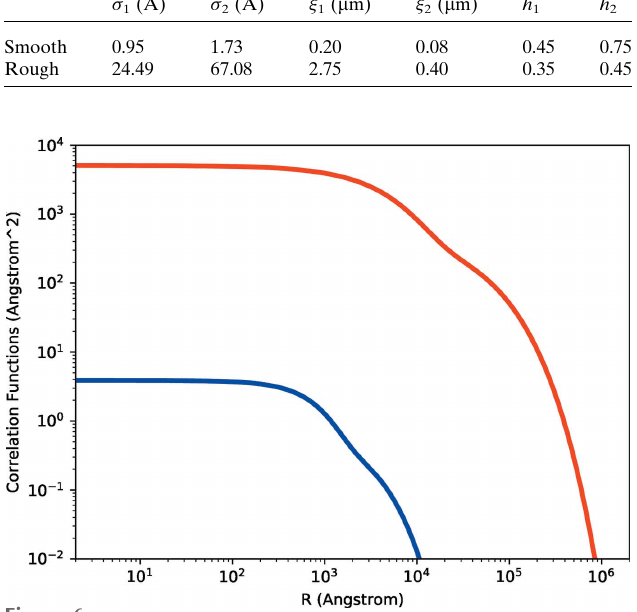
Figure 6 Correlation functions for the smooth (blue) and rough (red) samples obtained by optimizing fits to both: (i) the polynomial fits to the PSD data and (ii) the X-ray diffuse scattering